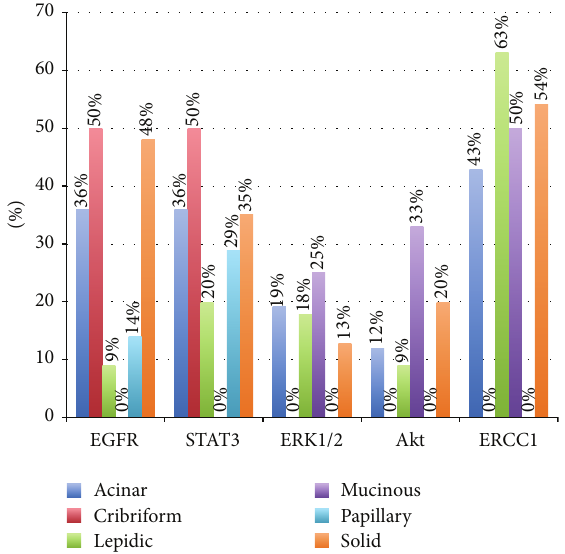
Figure 3: Percentage of expression of predominant histologic subtype of each immunohistochemical protein (EGFR, ERK1/2, STAT3, Akt, and ERCC1). The EGFR cutoff for positivity was the histologic score of